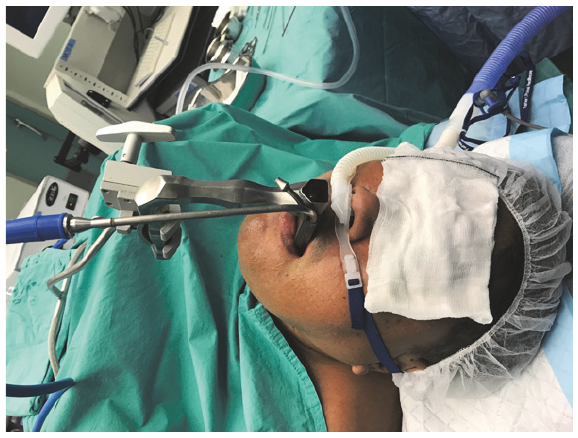
Figure 1: Setup of THRIVE intraoperatively, with the surgical suspension laryngoscope in